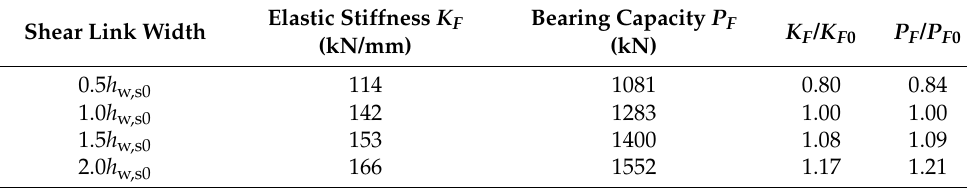
Figure 21. Load – displacement curves for different h w,s values. Table 6. Comparison of mechanical properties for different h w,s values.